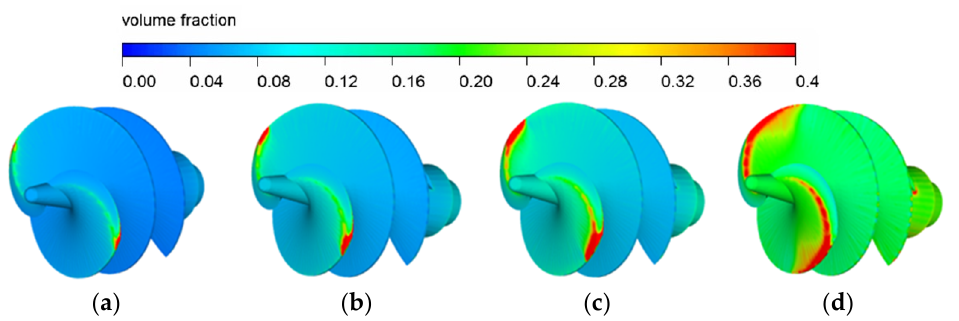
Figure 8. The vapor volume fraction distributions in the inducer: ( a ) NPSHa = 1.67 m; ( b ) NPSHa = 1.32 m; ( c ) NPSHa = 1.05 m; ( d ) NPSHa = 0.65 m.